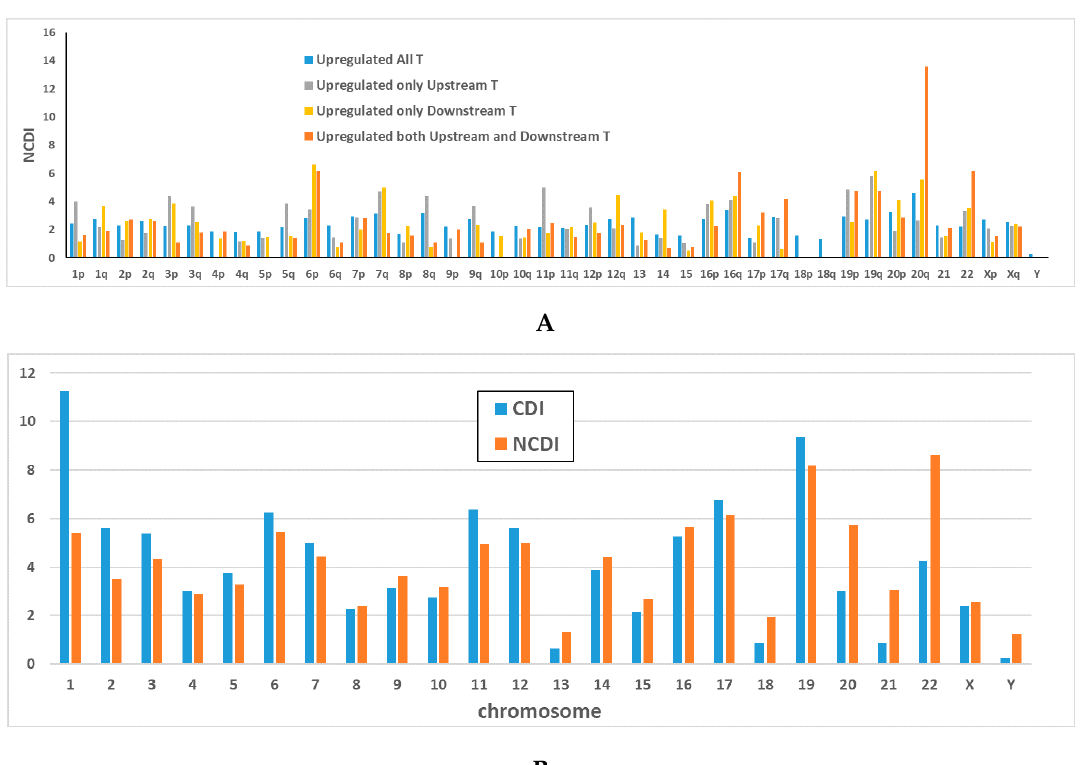
Figure 6. ( A ) Percentage chromosomal distribution of upregulated FuTAG’s parent genes normalized for the total number of transcripts in each chromosome (normalized chromosomal distribution index (NCDI)). ( B ) Percentage chromosomal distribution of 800 ConjoinG transcripts (Chromosomal distribution index (CDI)) and its normalized chromosomal distribution index, NCDI (CDI normalized for the total number of transcripts in each chromosome). Table 2. FuTAGs located in Chr20q and upregulated in comparison with normal mucosa in both parent genes. Data obtained by RNAseq have been explored in HTA 2.0.